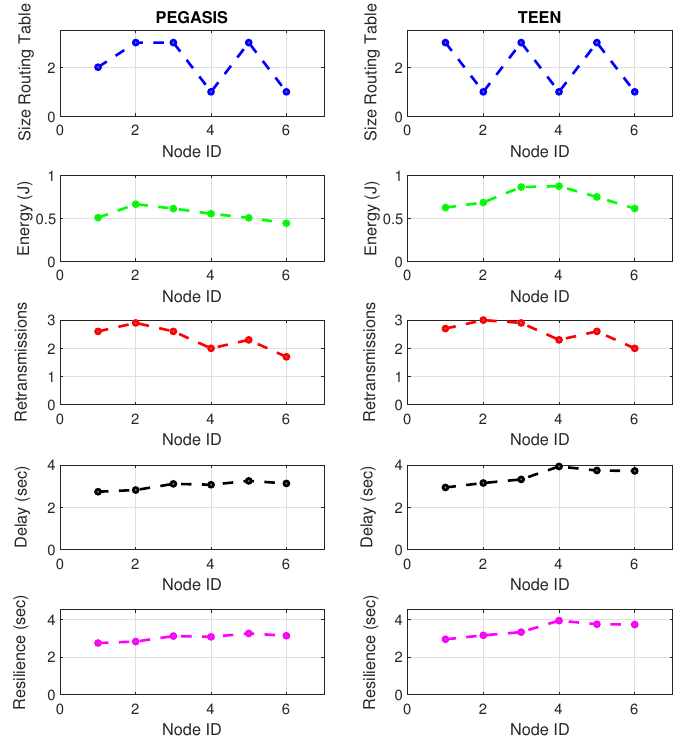
Figure 20. Zigbee network deployment under jamming conditions.